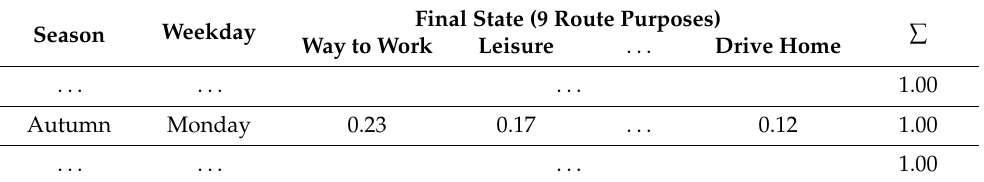
Table 2. Structure of the transition matrix for the route purposes of the car with exemplary